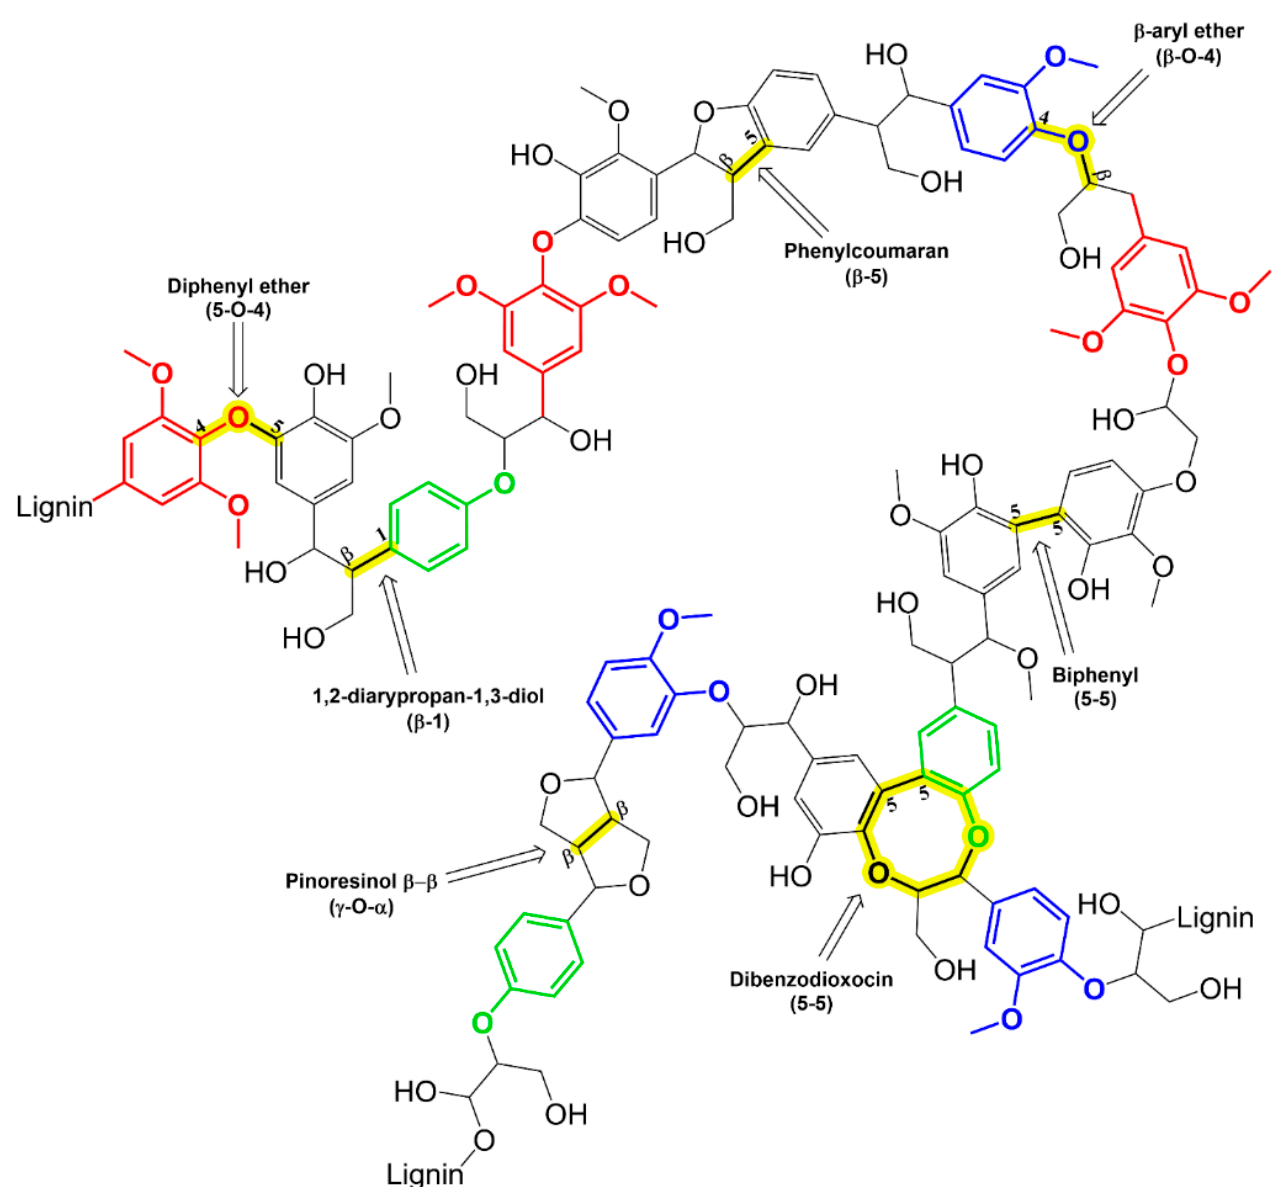
Figure 1. Schematic representation of the lignin structure. The figure shows the three main moieties: p -hydrophenyl (H) (green), guaiacyl (G) (blue) and syringyl (S) (red). The most frequent bonds are highlighted in yellow.